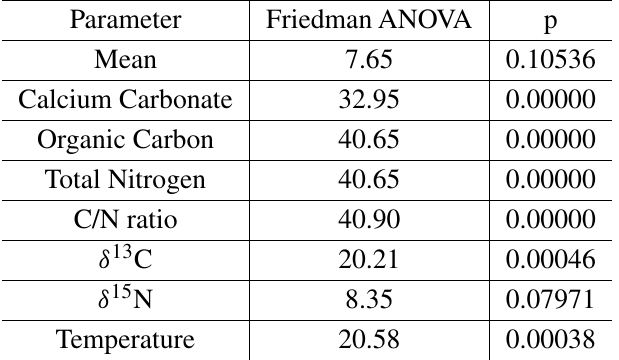
Friedman Analysis of Variance among the cores. Significant values ( α ⇐ 0 . 100 ) are